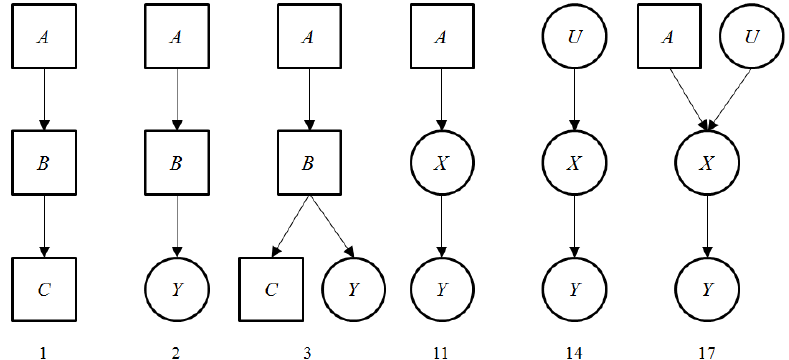
Figure 1. Possible Node Types for a Conditional Gaussian Hybrid BN (rectangle denotes discrete node; circle denotes continuous